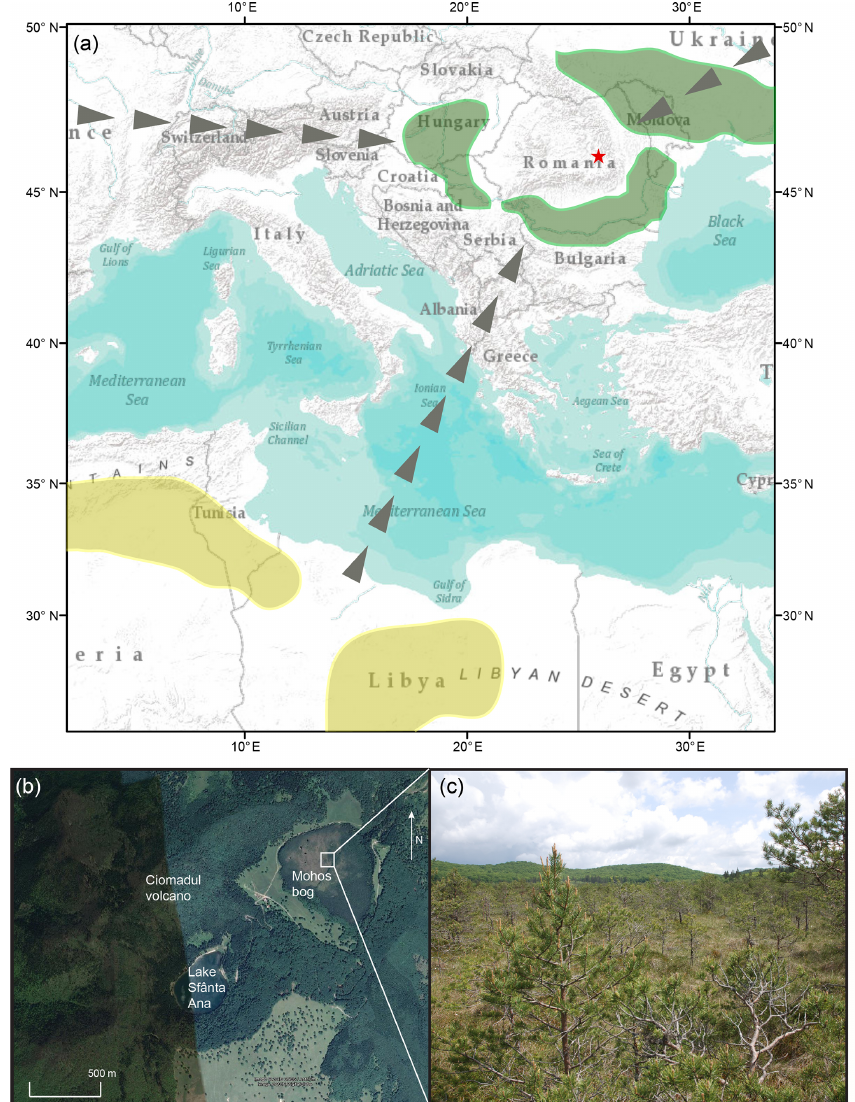
Figure 1. (a) Map of the Carpathian–Balkan region indicating location of Mohos peat bog (red star) in the southern Eastern Carpathian Mountains. Predominant wind directions relating to air circulation patterns in the area are indicated by black arrows. Major Saharan dust source areas are indicated in yellow (Scheuvens et al., 2013) and local loess fields (including loess-derived alluvium) in green (Markovi ´ c et al., 2015). (b) Map of Mohos and neighbouring Lake Sfânta Ana, from Google Earth 6.1.7601.1 (10 June 2016). Harghita County, Romania, 46 ◦ 05 (cid:48) N, 25 ◦ 55 (cid:48) E, eye altitude 3.06km, CNES/Astrium, DigitalGlobe 2016, http://www.google.com/earth/index.html. Coring location within white box. (c) Photo of Mohos bog at the coring location with the crater rim visible in the